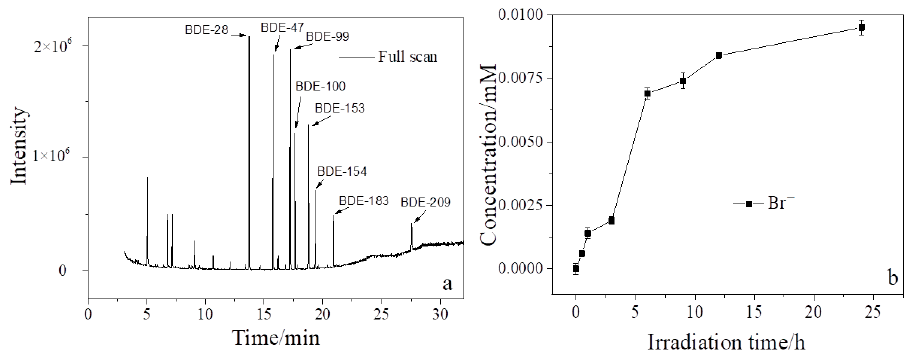
Figure 5. ( a ) GC-MS chromatograms of BDE-209 photodegradation; ( b ) the concentration of bromide ions in the reaction system.